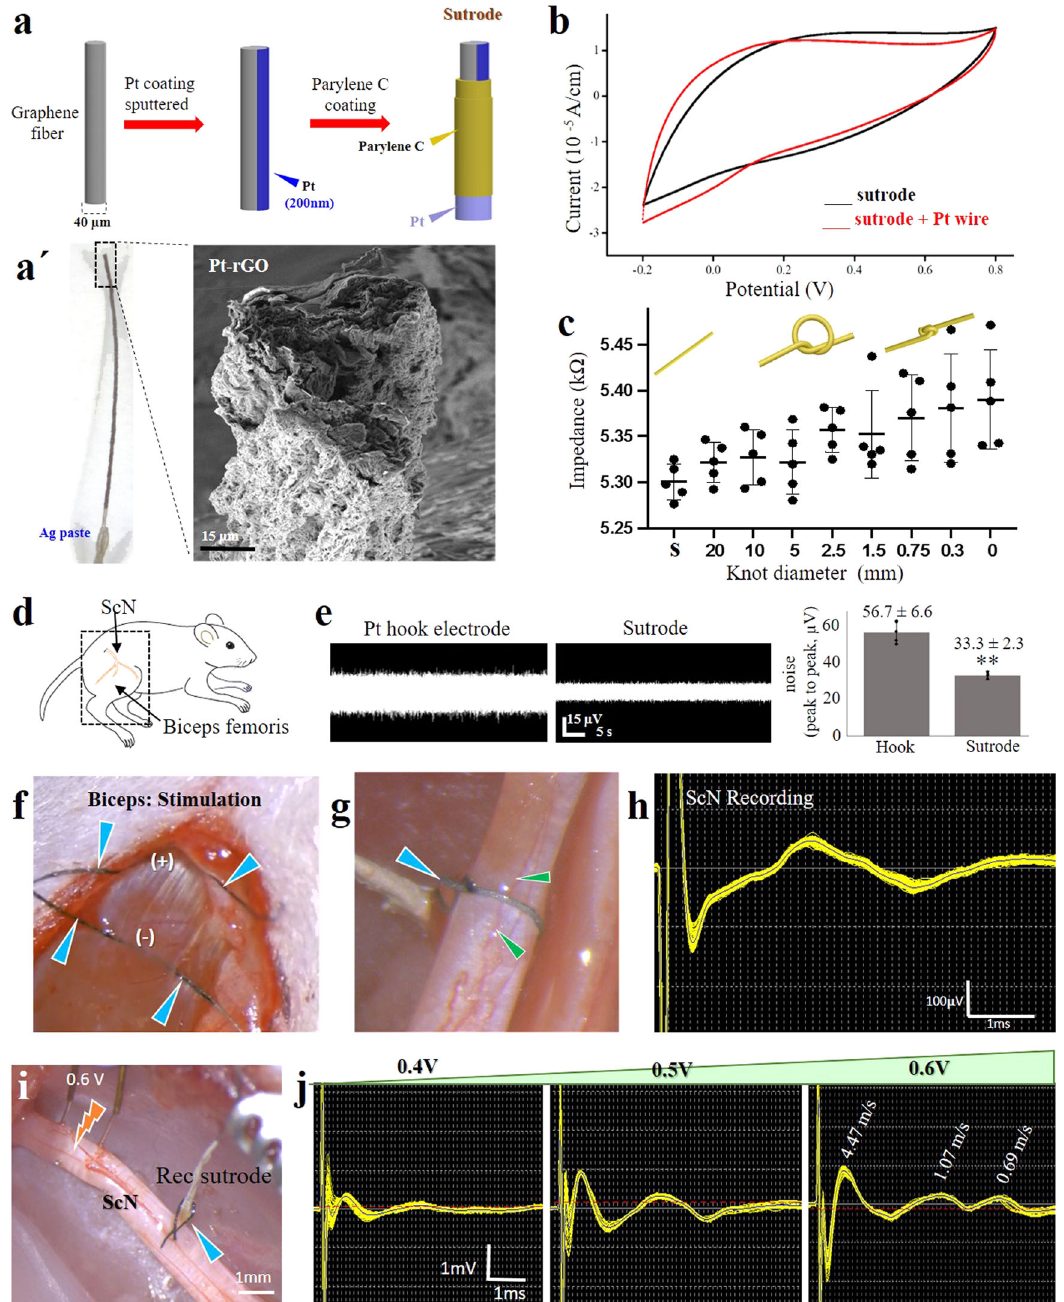
Fig. 1 Platinized graphene fi bers serve as suture and wrapping electrodes. a Coating steps of extruded Pt-rGO electrodes. a ’ Photograph and SEM. b Cyclic voltammetry of Pt-rGO fi bers before and after soldering to a Pt wire. c Graphene fi ber knotting does not signi fi cantly alter the electrode impedance. Individual impedance measurements and their mean and standard deviation are represented in the graphic during different knot diameters in the sutrode ( n = 5 sutrodes). d Illustration of the ScN and biceps femoris muscle. e Reduced base noise measurements of the sutrode compared to Pt hook electrodes in saline, graphics in the right were obtained from n = 5 independent experiments ** p < 0.01 (values represented as mean ± SD). f Sutrode placed on biceps (blue arrows) evoked effective muscle contraction (Supplementary Video 1). g Sutrode wrapped snugly on the ScN (blue arrow), without blood fl ow occlusion of super fi cial vasculature (green arrows) used to h record the evoked CNAP. i Stimulation of the tibial nerve fascicle with hook electrodes and recording with the sutrode (blue arrow), allowed the recording of j graded evoked CNAPs and the detection of B and C fi bers. Pt-rGO reduced liquid crystalline graphene oxide, s straight sutrode, ScN sciatic nerve, SEM scanning electron microscopy, CNAP compound nerve action